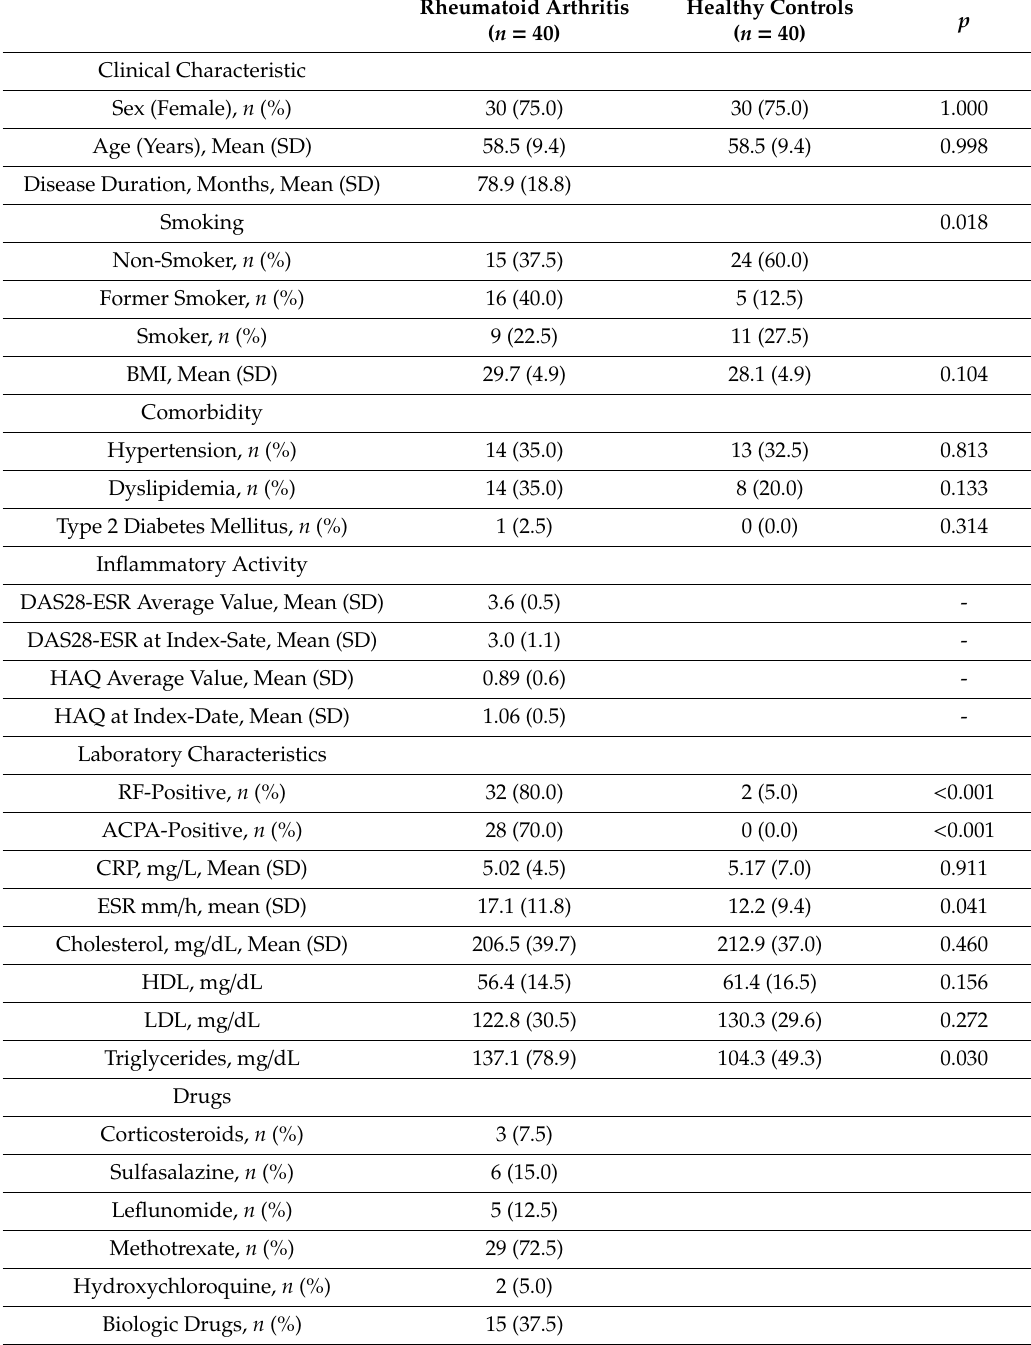
Table 1. Baseline characteristics of the study